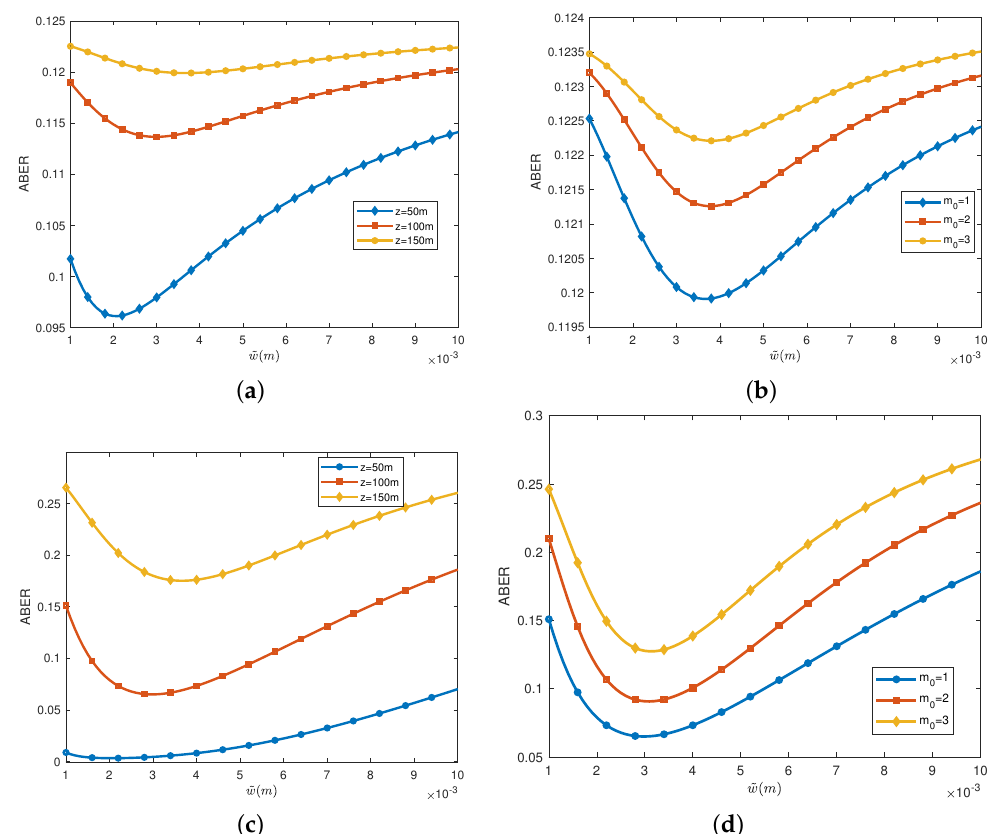
Figure 8. The bandwidth-limited ABER of POV carrier link versus the half beam-width ˜ w and